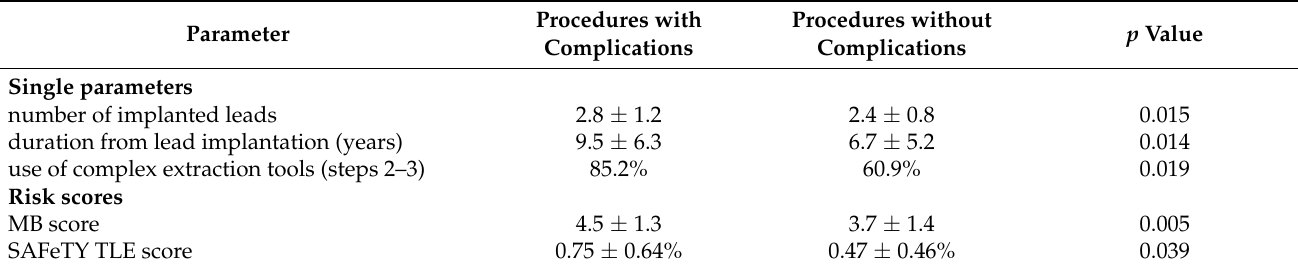
Table 4. Predictors for short-term